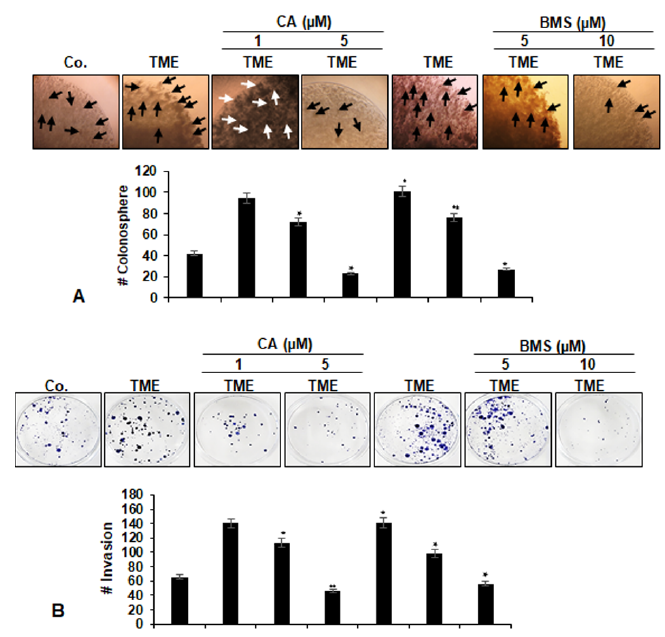
Figure 3. E ff ects of Calebin A (CA) or specific IKK inhibitor BMS-345541 on colonosphere formation and invasion in of CRC cells: Serum starved HCT116 cells in alginate (stars) were treated as described in Materials and Methods. Colonosphere formation ( A ) and invasion ( B ) were analyzed by light microscopy after 10 days. All experiments were performed at least three times. The number of colonospheres (arrows) was quantified by counting 25 di ff erent microscopic fields, and the number of attached colonies was quantified in each well. p < 0.05 (*) and p < 0.01 (**) indicate a significant di ff erence compared to the control group. Magnification A: × 24, bar = 0.2 mm.